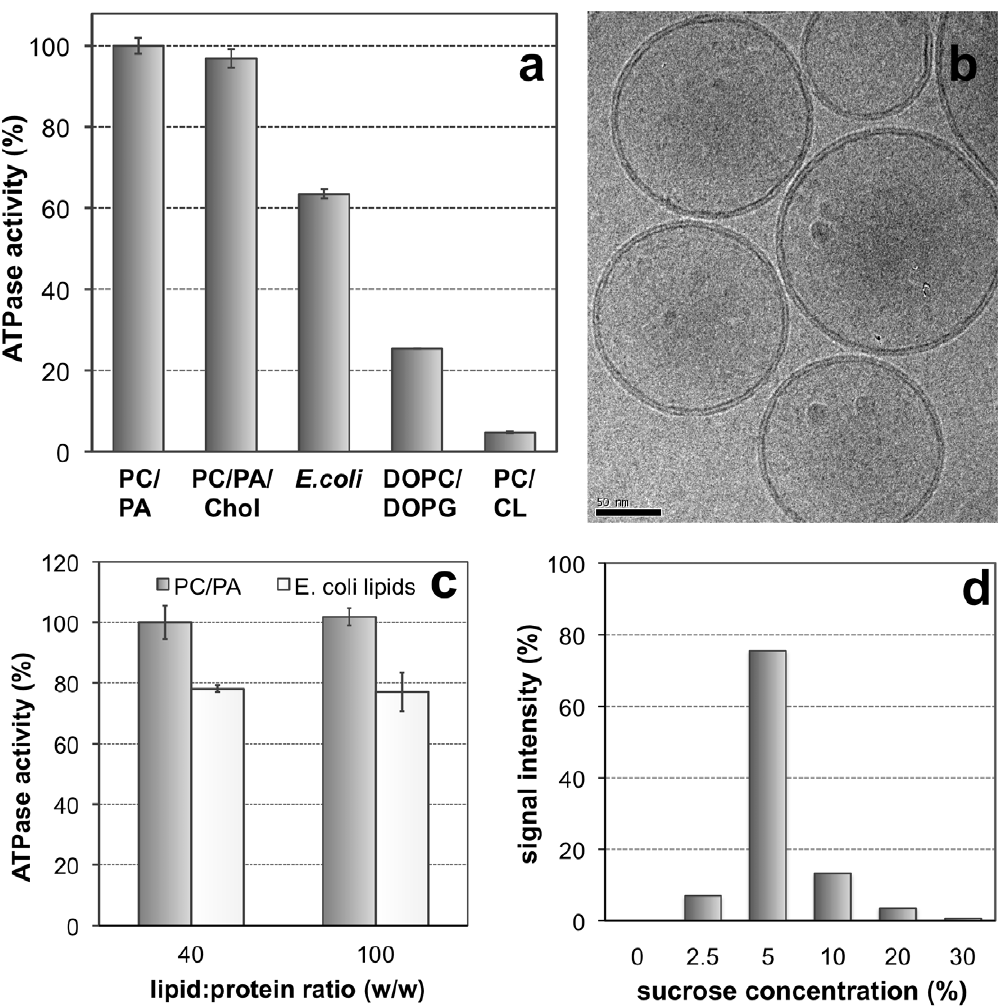
Figure 5. Reconstituted BmrC/BmrD displays a high and substrate-stimulated ATPase activity. ( a ) BmrC/BmrD was reconstituted into proteoliposomes using a mixture of PC/PA (9:1, molar ratio), and the effect of ATP/Mg 2 + concentration on the initial ATPase velocities was determined. The solid line represents the best fit of the data to Michaelis-Menten equation (using the GraFit 5 software from Erithacus ), allowing the determination of